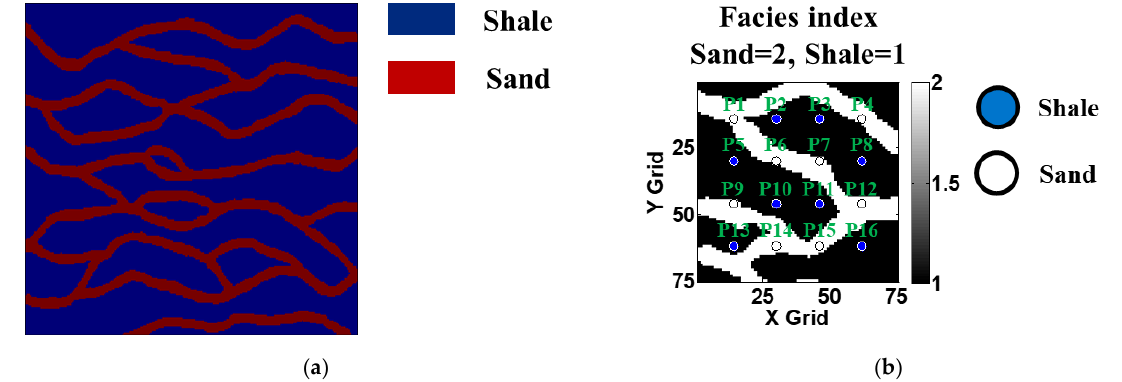
Figure 7. Training image for ( a ) SNESim and ( b ) the reference field.